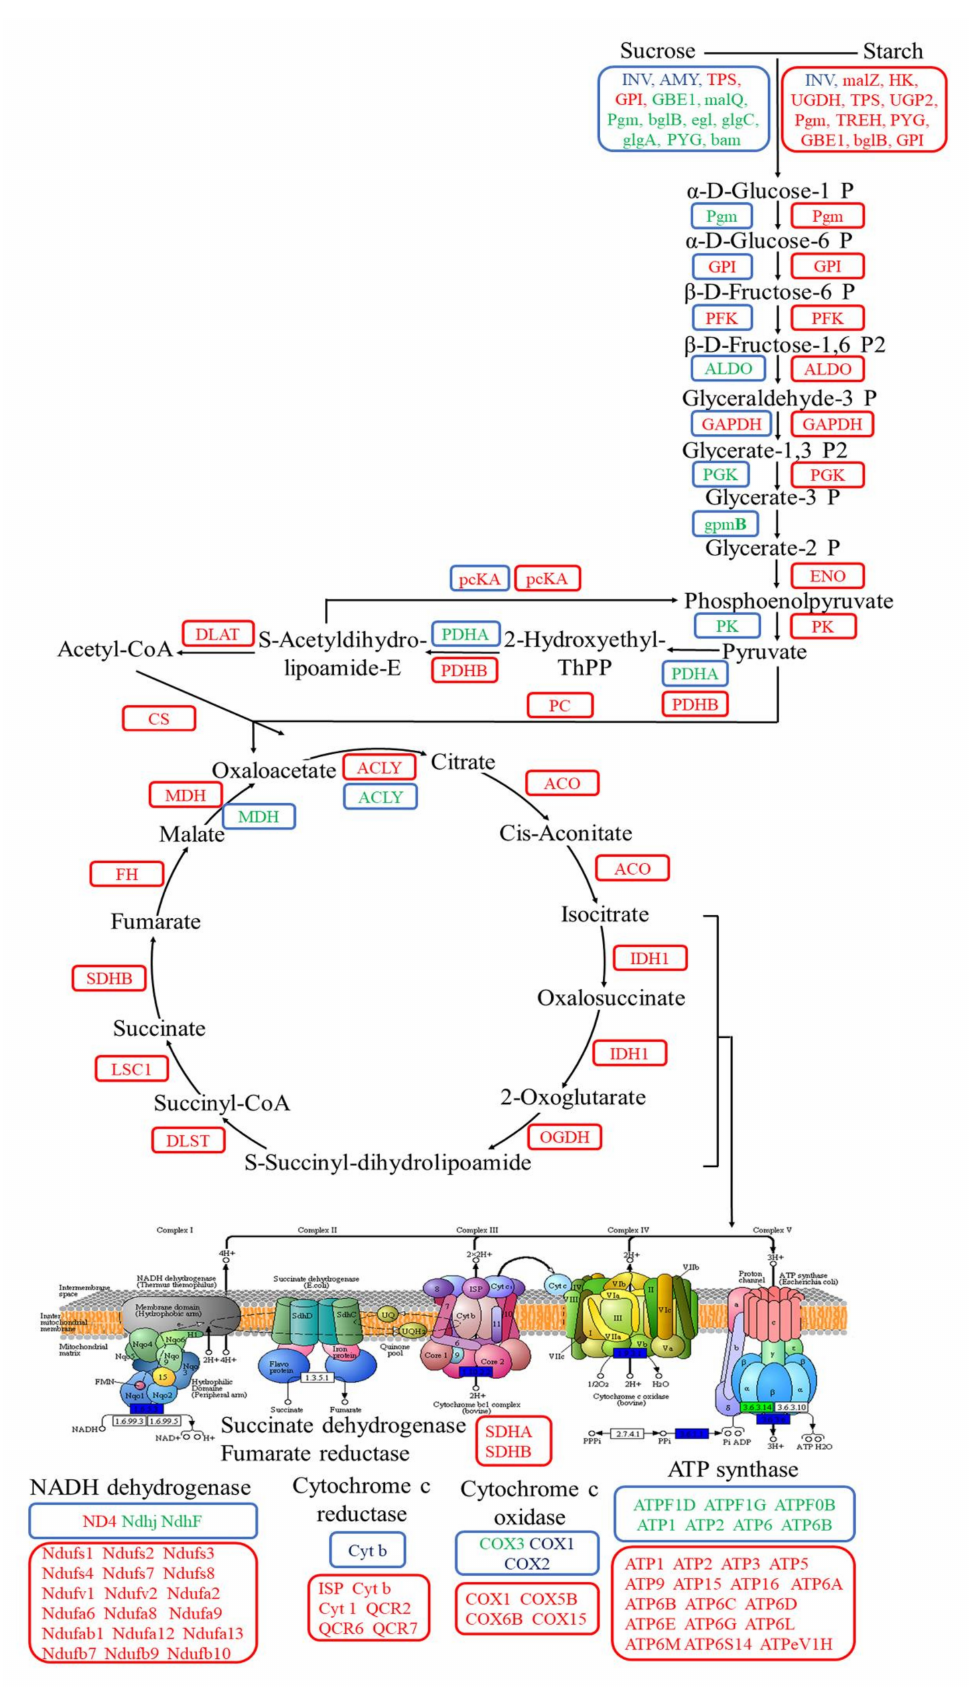
Figure 8. The expression of differentially expressed genes (DEGs) related to energy metabolism in aboveground and